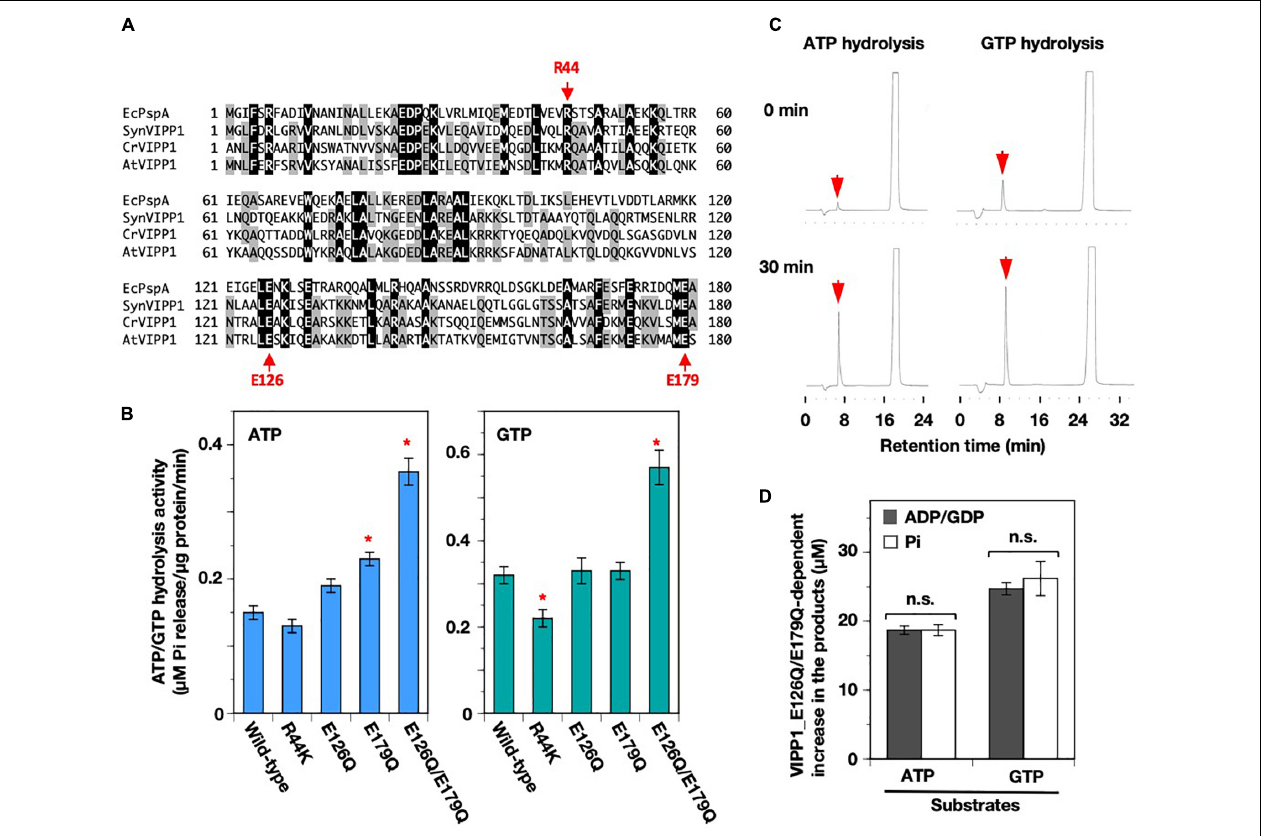
FIGURE 6 | Mutations in the nucleotide-binding pocket predicted from the structure of SynVIPP1. (A) Multiple alignment of partial amino acid sequence (1–180) among a PspA ( Escherichia coli ) and three VIPP1s ( Synechocystis , Chlamydomonas , and Arabidopsis ). The amino acids that contribute to ATP/GTP-binding in cyanobacterial VIPP1 are shown with arrows (R44, E126, and E179). (B) ATP- and GTP-hydrolysis activities of wild-type and four point-mutated proteins were analyzed based on Synechocystis VIPP1 previously. Asterisks in the bar graphs denote significant differences in activity from the wild-type protein (Welch’s t-test with p < 0.01). (C) Representative elution profiles of ADP and GDP obtained from the reactions of E126Q/E179Q mutant protein. (D) The level of major products obtained in 30-min hydrolysis reactions. There were no significant differences between the values of graphs, which is shown as “n.s.” according to a statistical analysis (Welch’s t -test, p < 0.01). Error bars: ±